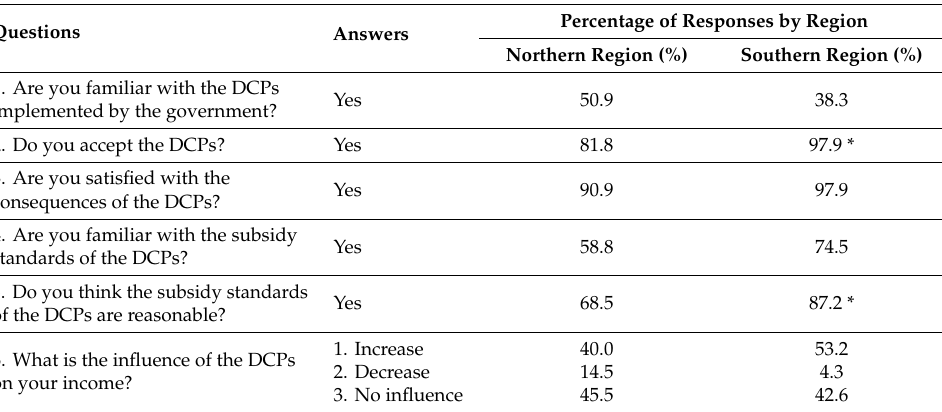
Table 3. Farmers’ attitudes towards the DCPs.